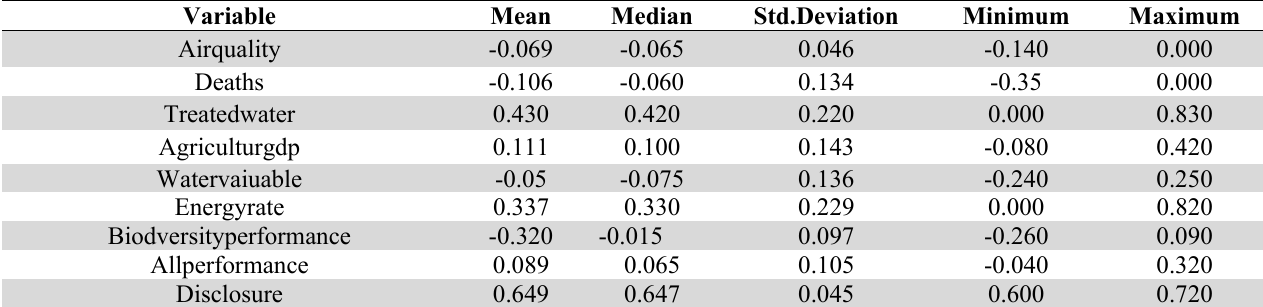
The results of descriptive